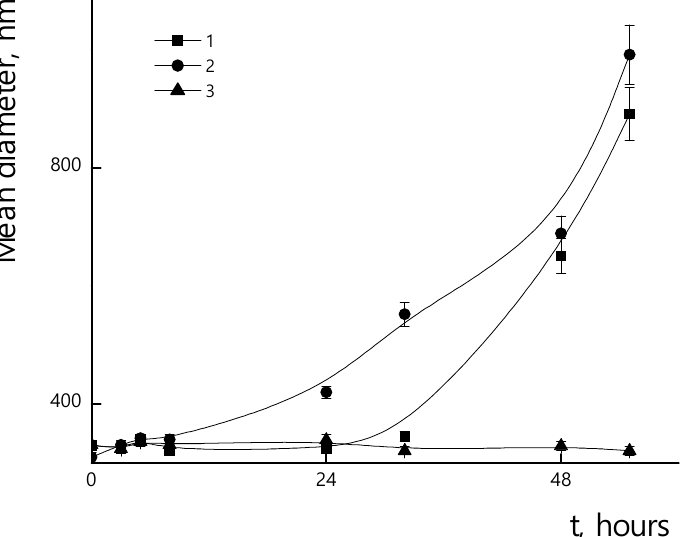
Figure 15. Mean hydrodynamic diameters of PLAMs–PTX suspensions with trypsin during incuba- tion. Concentration of PLAMs 0.5 mg/mL, concentration of trypsin 4 mg/mL, Tris buffer with pH 7, temperatures 25 °C (1); 37 °C (2); 7 °C (3).